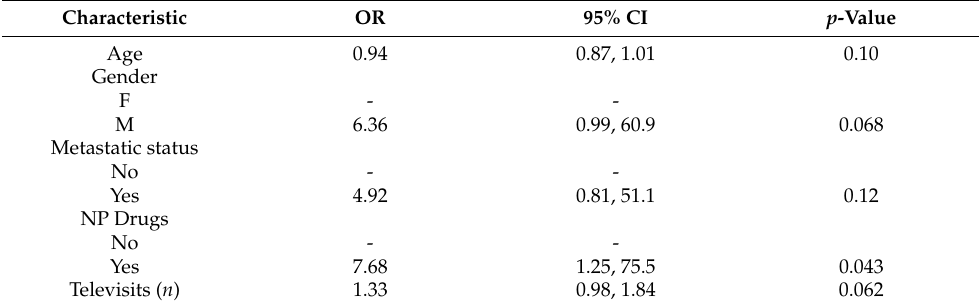
Table 4. Multivariate analysis.